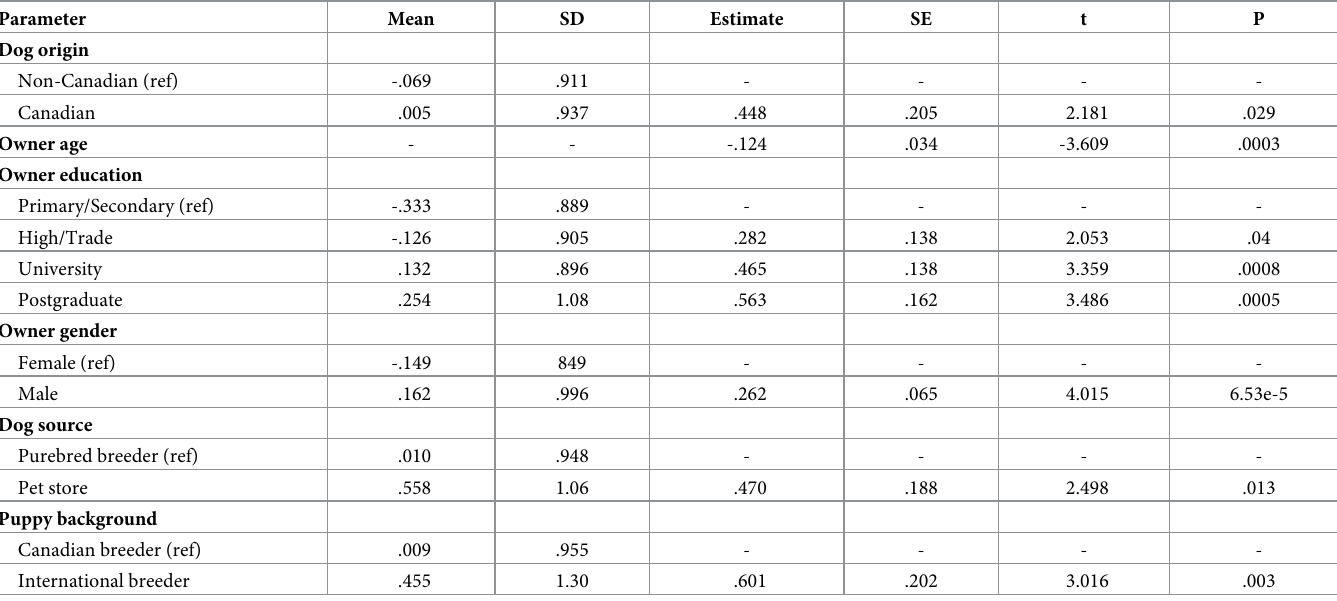
Table 6. Statistically significant interactions of owner and dog parameters on MDORS Factor 1 “Struggle”.